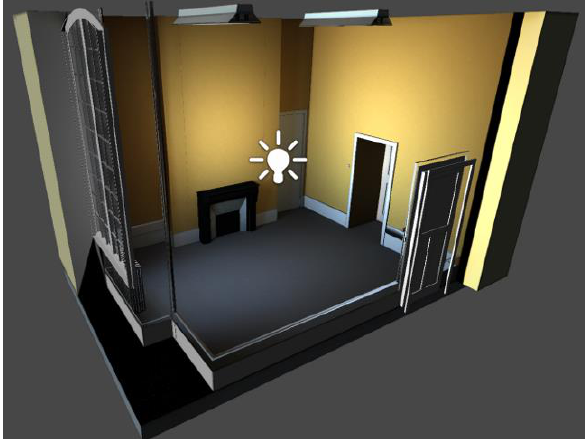
Figure 5. "as-defined" model in Unity3D